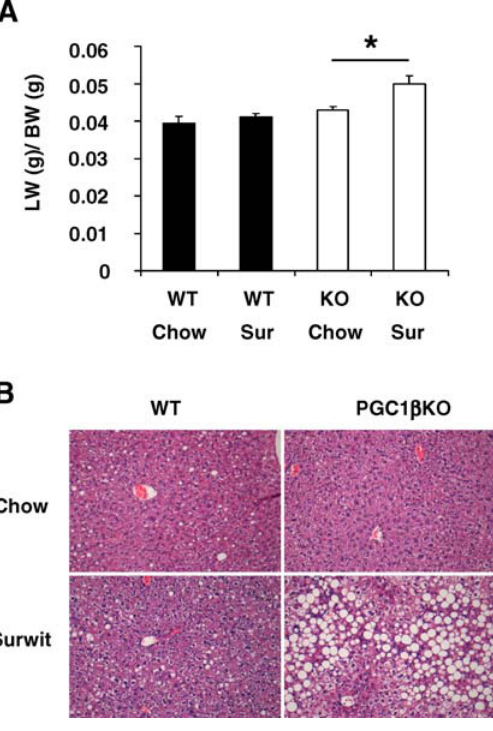
Figure 9. PGC1 b KO Mice Demonstrate Increased Liver Mass and Development of Fatty Liver after 24 h HFD Female 8-wk-old mice were given normal chow or Surwit HFD (Sur) for 24 h. Tissues were then collected for analysis. (A) Liver weight, as standardized by body weight (LW/BW) for WT (black bars) and PGC1 b KO (white bars) after 24 h diets. (B) Representative histological sections from mice given normal or Surwit diet for 24 h. n ¼ 6–7 mice per group. DOI: